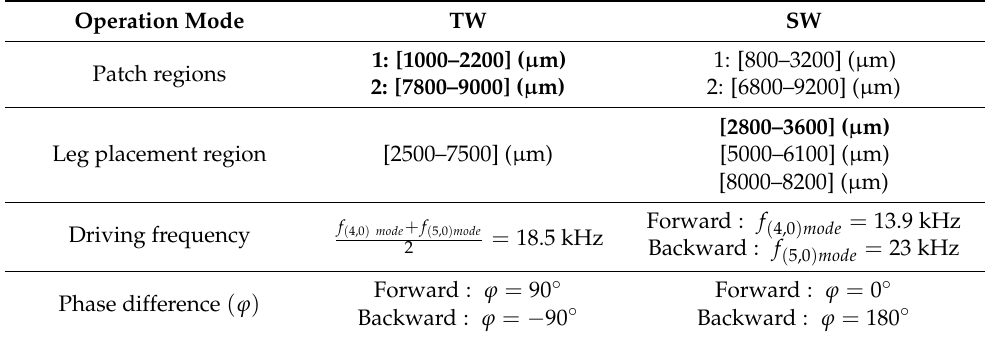
Table 1. Summary of the design parameters and excitation conditions for the hybrid linear motor, driven by travelling or standing waves. The chosen parameters for the motor are highlighted in bold type.